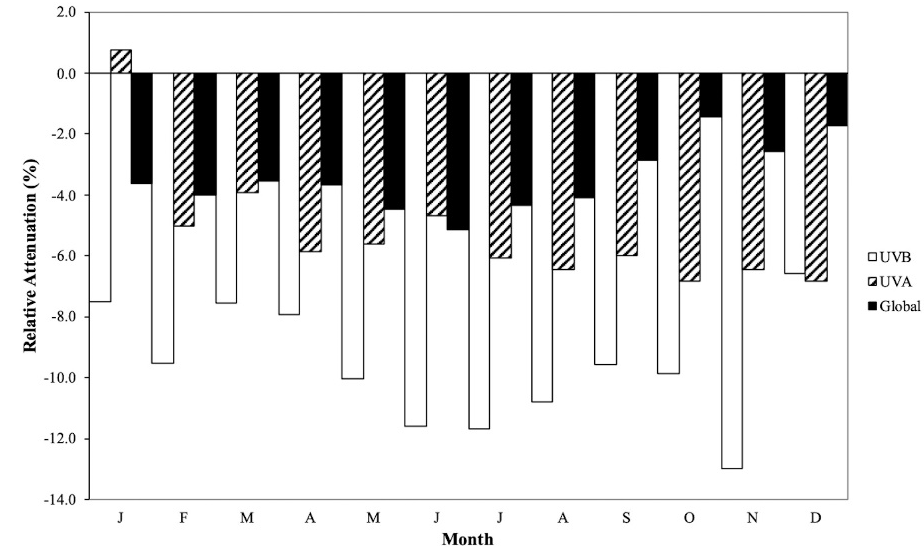
Figure 1. Monthly average daily % relative attenuation of irradiation intensities of global, UVB and